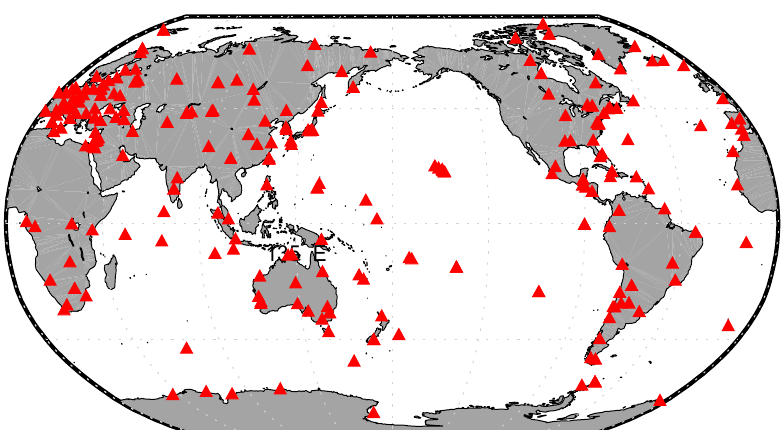
Figure 1. The 387 used GPS tracking sites (red triangles) selected from the ITRF2008 GPS network. Except for GPS ground observations, its stochastic model must be provided when we employ least-squares adjustments. Through the power spectral method and the maximum likelihood estimation method, several studies have recognized that the GPS time series was best described as a combination of white noise and flicker noise [29,30]. For simplicity, 24 global even distribution of stations among 387 GPS tracking sites are selected as examples to show the noise characteristics of GPS timeseries (Figure 2a,b). The magnitudes of flicker noise are about 2–5 times greater than those of white noise in all three directions. Furthermore, the noises in vertical directions are somewhat greater than in the horizontal direction.